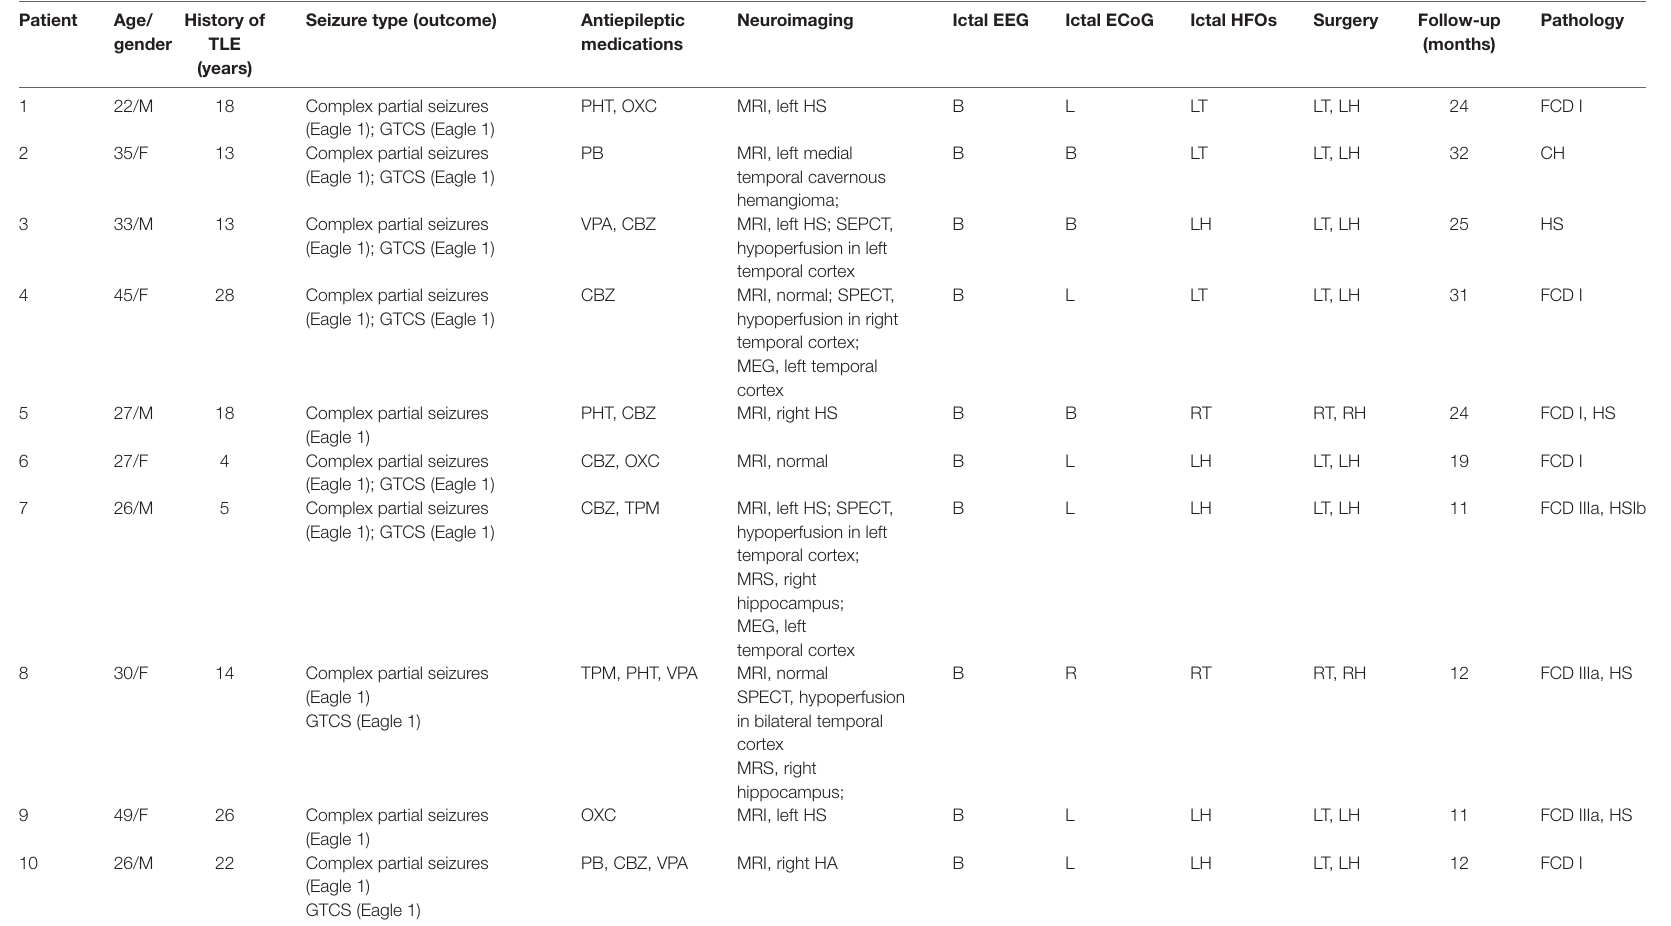
TABLE 2 | Clinical characteristics of the suspected bilateral temporal epileptic